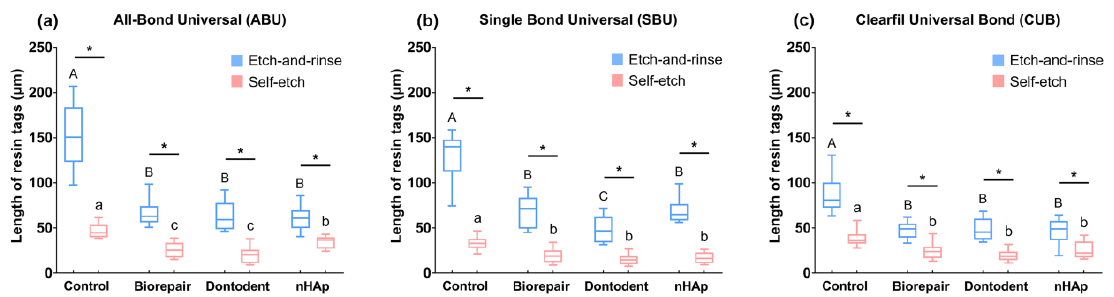
Figure 7. Adhesive resin infiltration observation in etch-and-rinse mode or self-etch mode. ( a ) All-Bond Universal (ABU). ( b ) Single Bond Universal (SBU). ( c ) Clearfil Universal Bond (CUB). Long homogeneous resin tags formed in etch-and-rinse mode and short resin tags formed in self-etch mode. ER: etch-and-rinse mode; SE: self-etch mode.